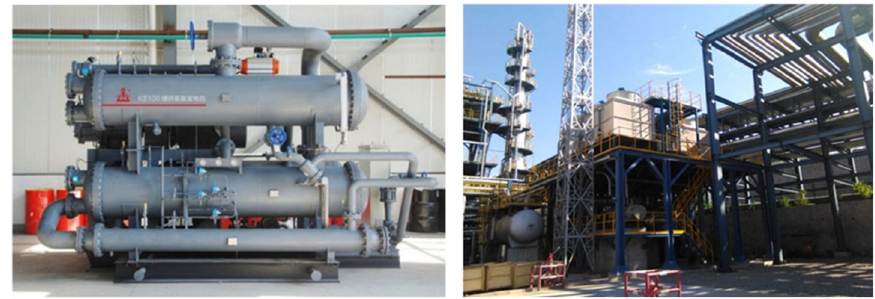
Figure 9. The screw expanding power generator of China petroleum and chemical corporation, Beijing Yanshan branch.